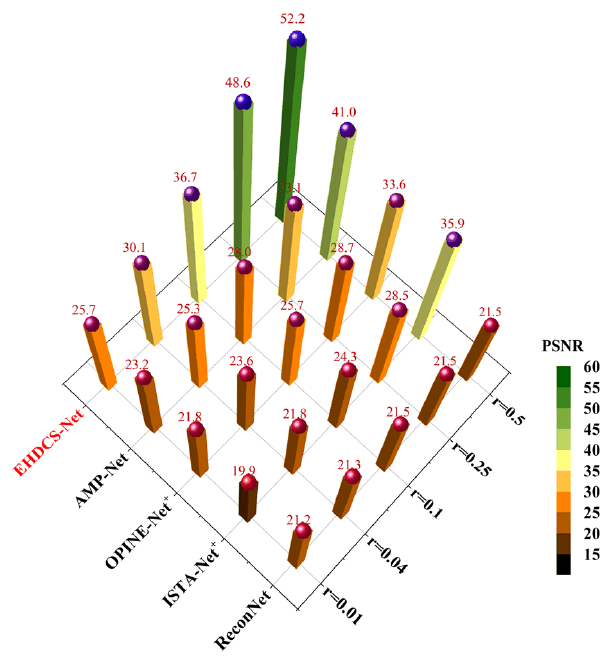
Figure 13. Comparison of average PSNR values of different deep learning-based image CS methods evaluated on the test set at different CS ratios.